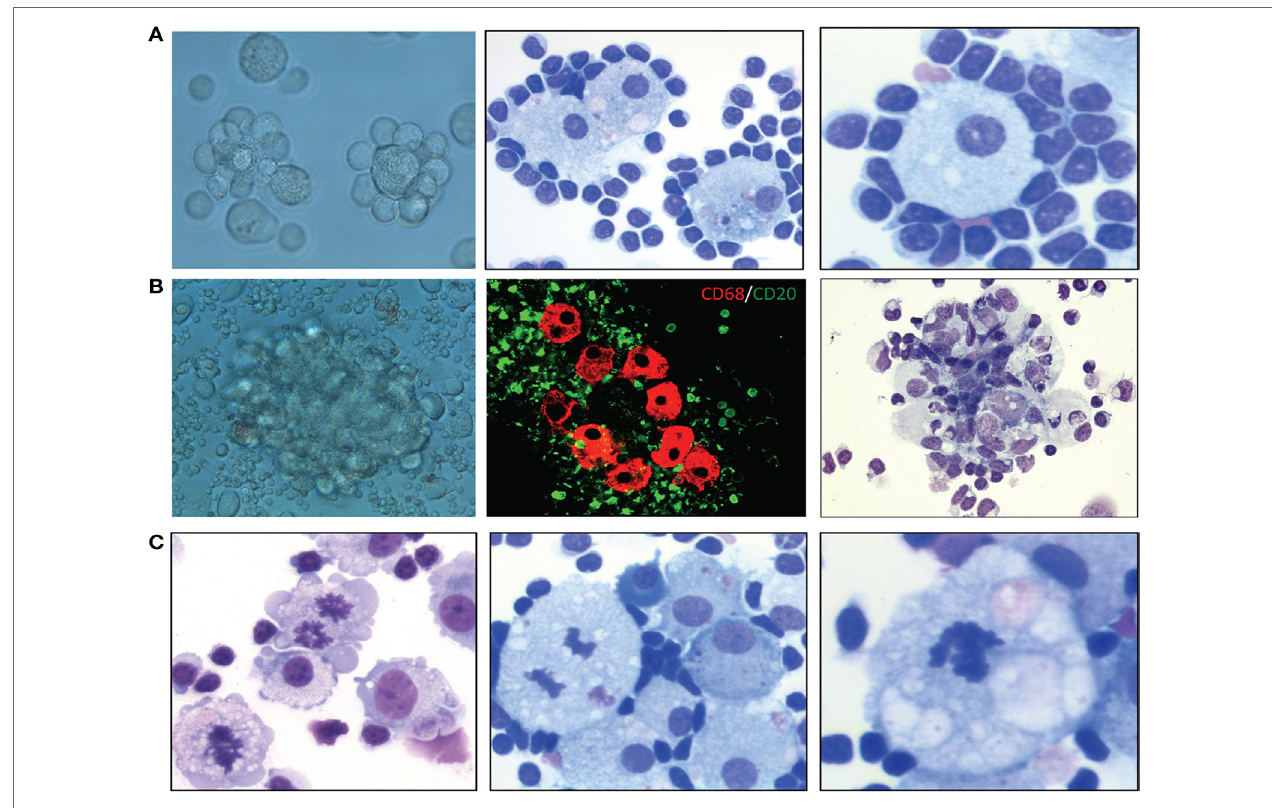
FigURe 1 | Characterization of lymphoma-associated macrophages (MPs) in B-cell lymphoma cell cultures. (A) Examples of lymphoma cell–tumor-associated MP colony aggregation in culture after 2 weeks. Left, phase-contrast light microscopic image; middle, Wright–Giemsa stain (400 × ); right, Wright–Giemsa stain (400 × ). (B) Examples of MP clustering/aggregation in mantle cell lymphoma (MCL) cell culture under hypoxic conditions. Left, phase-contrast light microscopic image; middle, confocal microscopic analysis of CD68 + MPs (red) and CD5 + cells (green); right, hematoxylin and eosin stain (200 × ). (C) Hematoxylin and eosin and Wright–Giemsa stains showing mitotic figures in MPs in primary MCL culture after 8 weeks under hypoxic conditions (400 ×